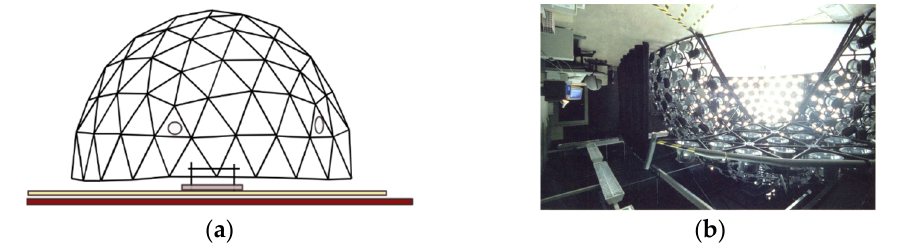
Figure 2. Electronically controlled artificial skydome design: ( a ) schematic diagram and ( b ) proto- type.